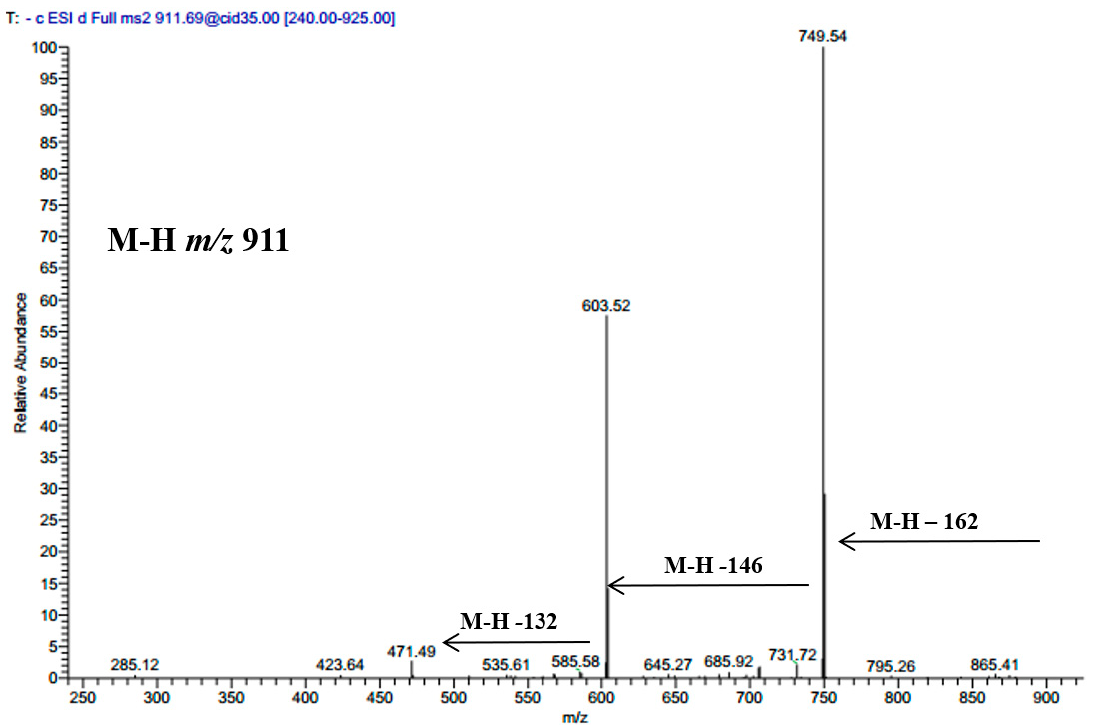
/ MS spectrum of deprotonated compound 27 at m / z Figure 2. MS/MS spectrum of deprotonated compound 27 at m / z 911. Figure 2. MS